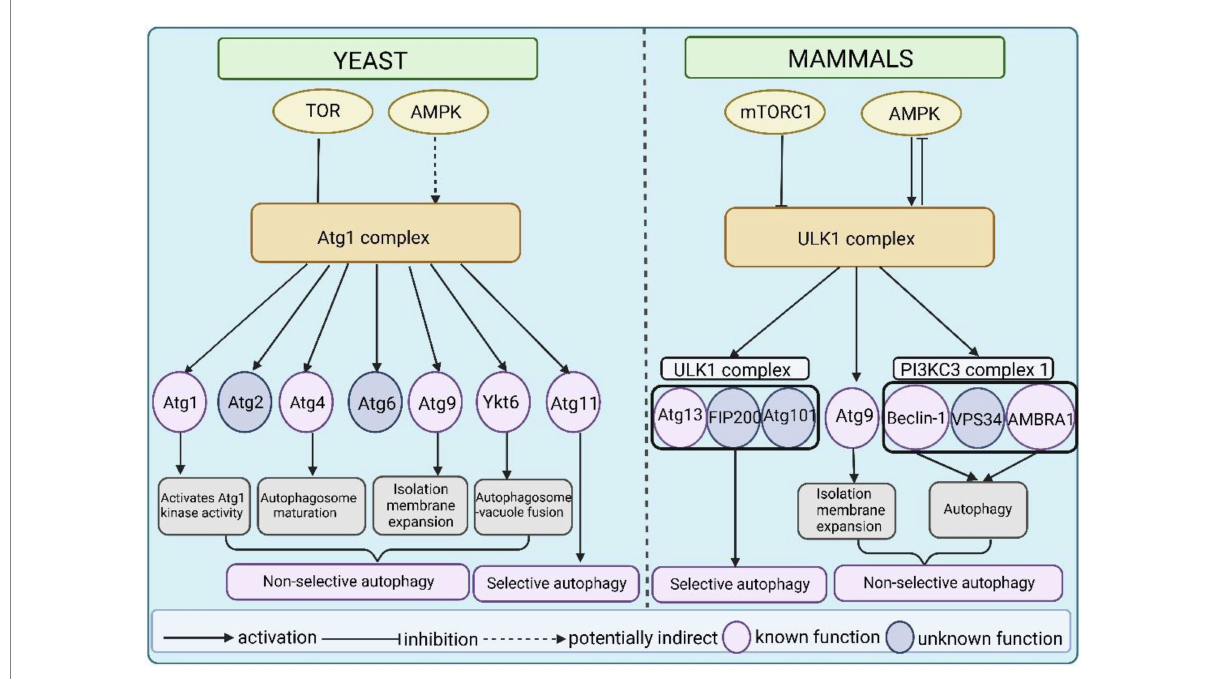
FIGURE 4 A model of the Atg1/ULK1 complex as an important hub linking upstream signals and downstream regulators in yeast and mammals. The activity of Atg1 and ULK1 is directly or indirectly regulated by TOR and AMPK. In yeast, Atg1 autophosphorylation is essential for activating Atg1 kinase activity. Atg1 phosphorylates Atg4 to promote autophagosome maturation. Atg1 phosphorylates Atg9 to promote isolation membrane expansion. Atg1 phosphorylates Ykt6 to control autophagosome–vacuole fusion. And Atg1 phosphorylates Atg11 and is essential for selective autophagy. Atg1 also phosphorylates Atg2 and Atg6, but the function of these phosphorylation events is not clear. In mammals, ULK1 phosphorylates its complex binding components Atg13, FIP200, and Atg101. Among these components, phosphorylation of Atg13 by ULK1 plays an important role in mitophagy, but the function of phosphorylation of the other two remains unclear. Similar to yeast, ULK1 phosphorylates Atg9 to regulate isolation membrane expansion. The phosphorylation of beclin-1 and AMBRA1 is required for autophagy induction but the function of Vps34 phosphorylation is not